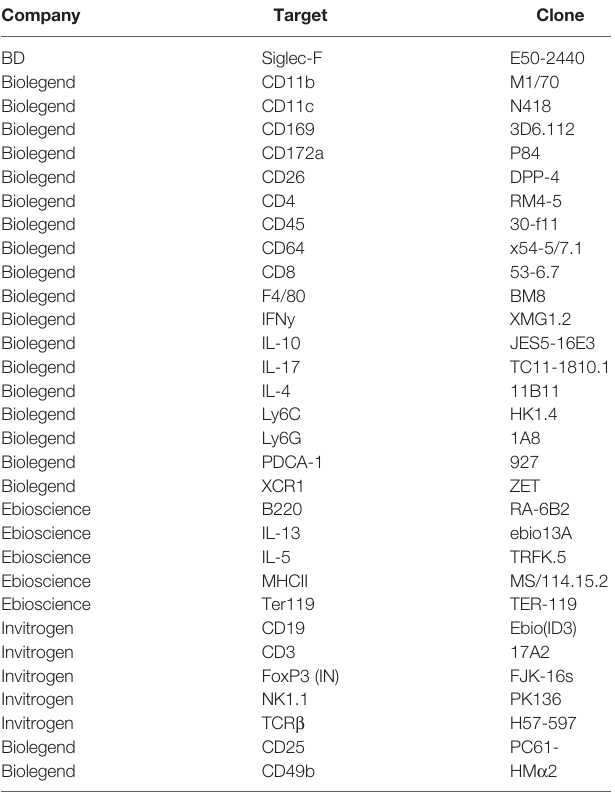
TABLE 1 | List of fl ow cytometry antibodies and their clones.